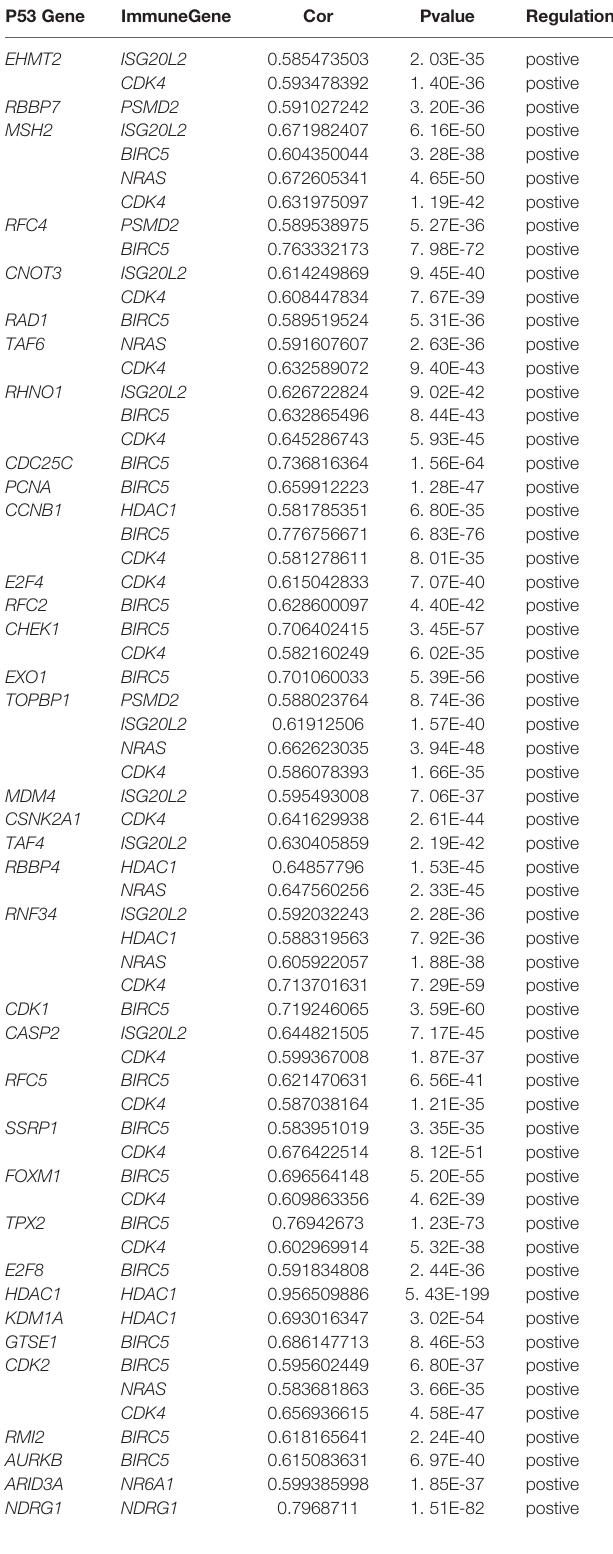
TABLE 3 | Details of the genes involved in the construction of regulatory